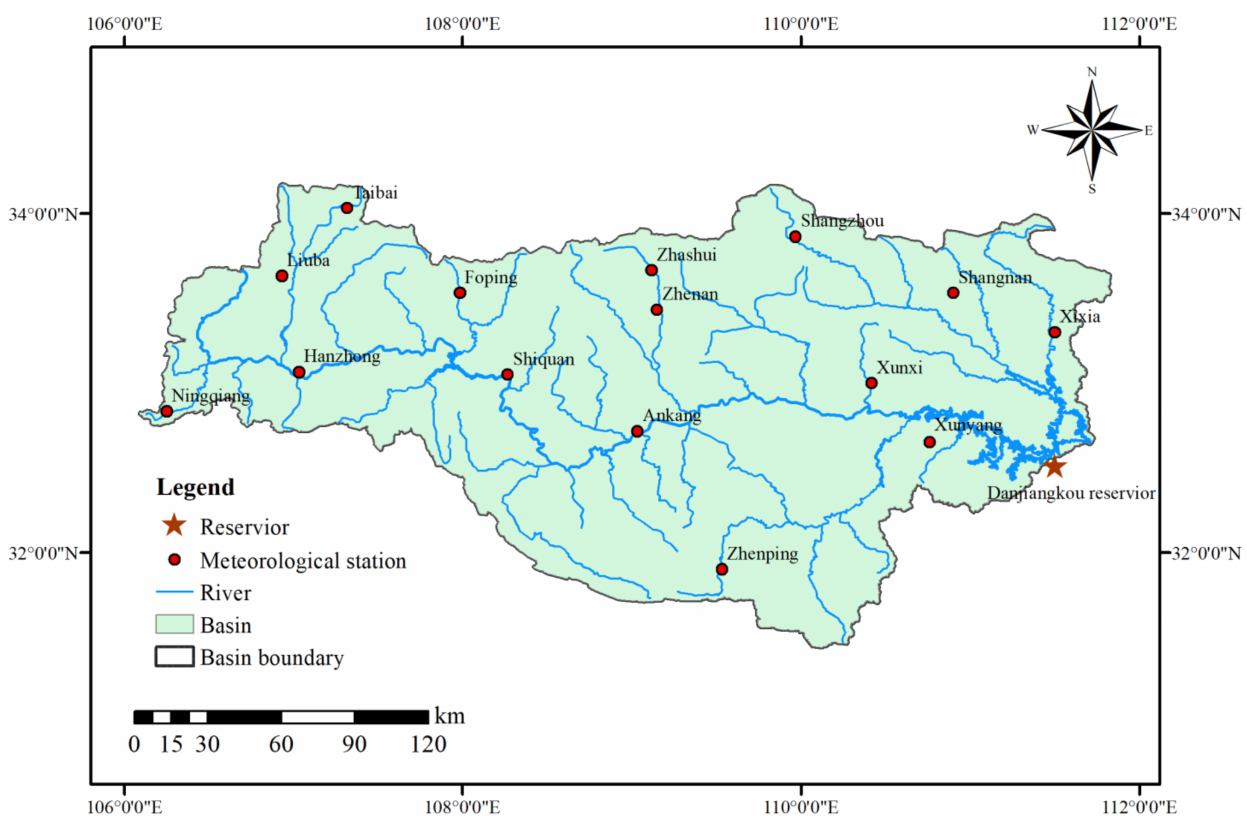
Figure 2. The region of Upper Hanjiang River Basin (UHRB) in